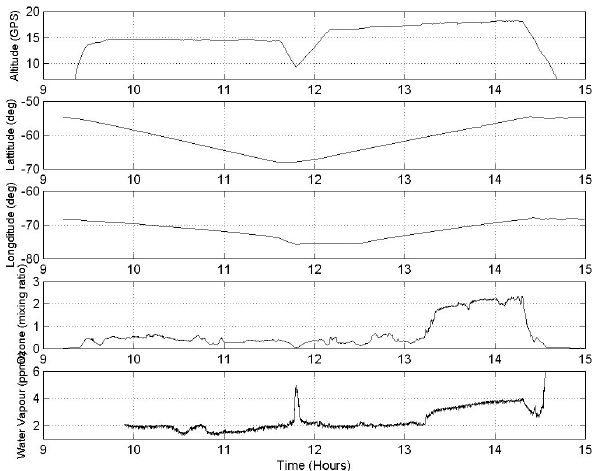
Fig. 1. Altitude, latitude, longitude, ozone and water vapour as a function of time for the 21 September 1999 flight. Note that as the stratosphere is relatively dry in comparison with the troposphere, the water vapour data in subplot (e) has been enlarged so that the stratospheric portion can be clearly